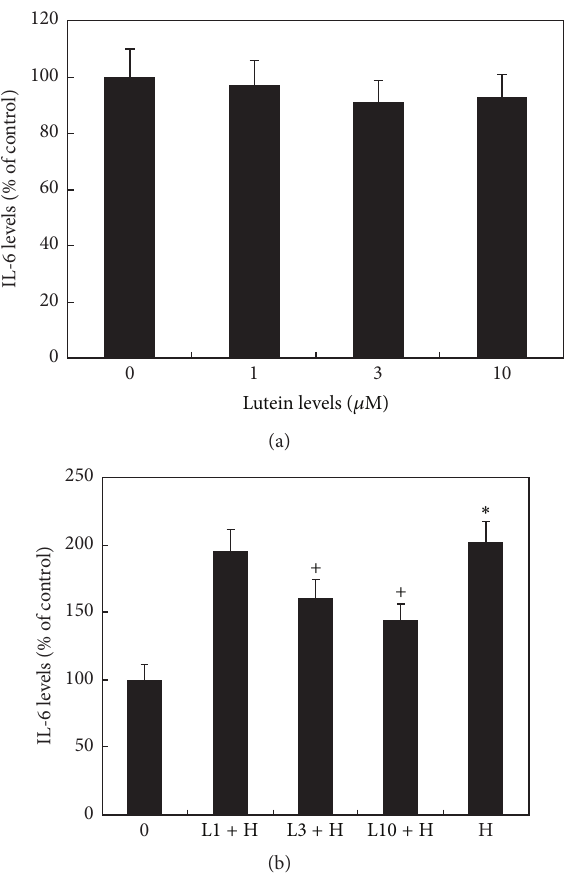
Figure 2: Effects of lutein and hyperosmotic medium on the secre- tion of IL-6 by cultured human CE cells. Cells were cultured with isoosmotic medium (0) or hyperosmotic medium (H) at 450 mOsM (b) with or without lutein at 1 𝜇 M (L1), 3 𝜇 M (L3), and 10 𝜇 M (L10) for 24 h. IL-6 levels of conditioned medium were measured by IL-6 ELISA kit. Hyperosmotic medium caused a significant increase of IL-6 levels ( ∗ 𝑃 < 0.05 ) as compared to cells cultured in isomer medium (0). Lutein at 3 and 10 𝜇 M significantly inhibited hyperosmoticity-induced increase of IL-6 secretion ( + 𝑃 < 0.05